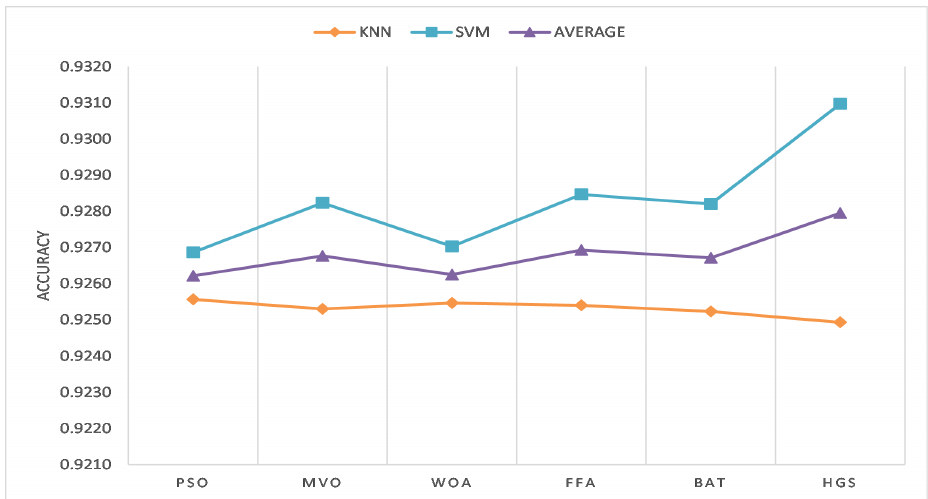
Figure 10. Distribution of the two classifiers based on FS